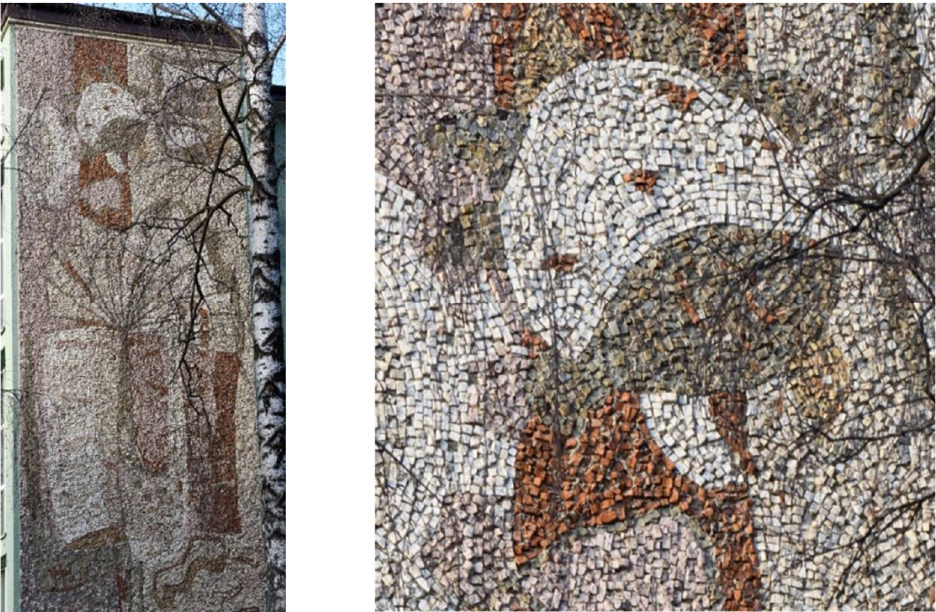
Figure 5. The “Education” mosaic on the facade of the “Petru Rareş” National College. (Source: Petru Palamar).